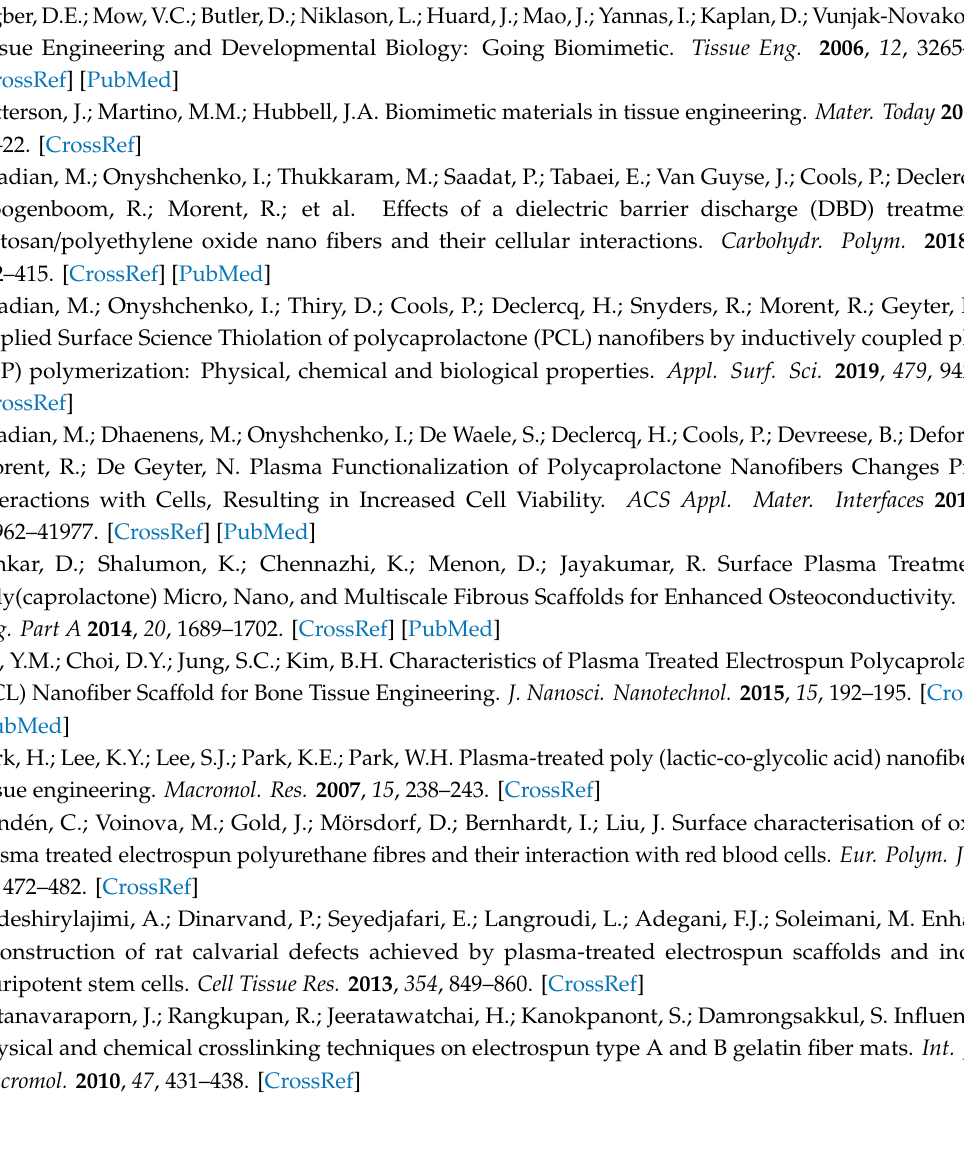
Figure S1: Fluorescence images at higher magnification of HFFs adhering on ( a ) untreated PCL NFs and ( b – h ) PPFs prepared using various deposition durations (( b ) 10 s, ( c ) 20 s, ( d ) 60 s, ( e ) 90 s, ( f ) 120 s, ( g ) 240 s and ( h ) 360 s) 7 days after cell seeding., Video S1: Water contact angle of untreated nanofiber., Video S2: Water contact angle PCL NF after 10 s plasma